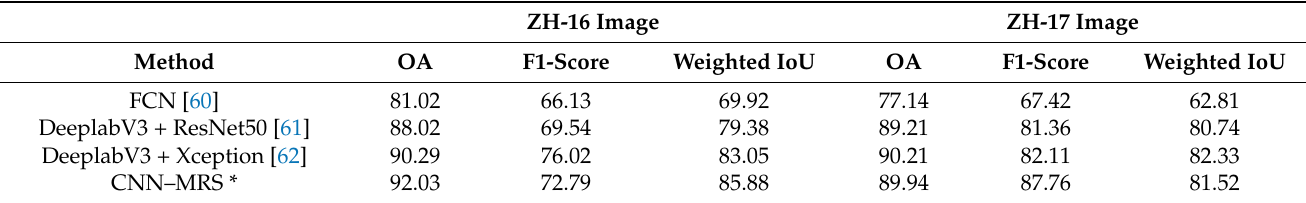
Table 17. Comparison with other approaches on Zurich Summer dataset (The values are given as %).